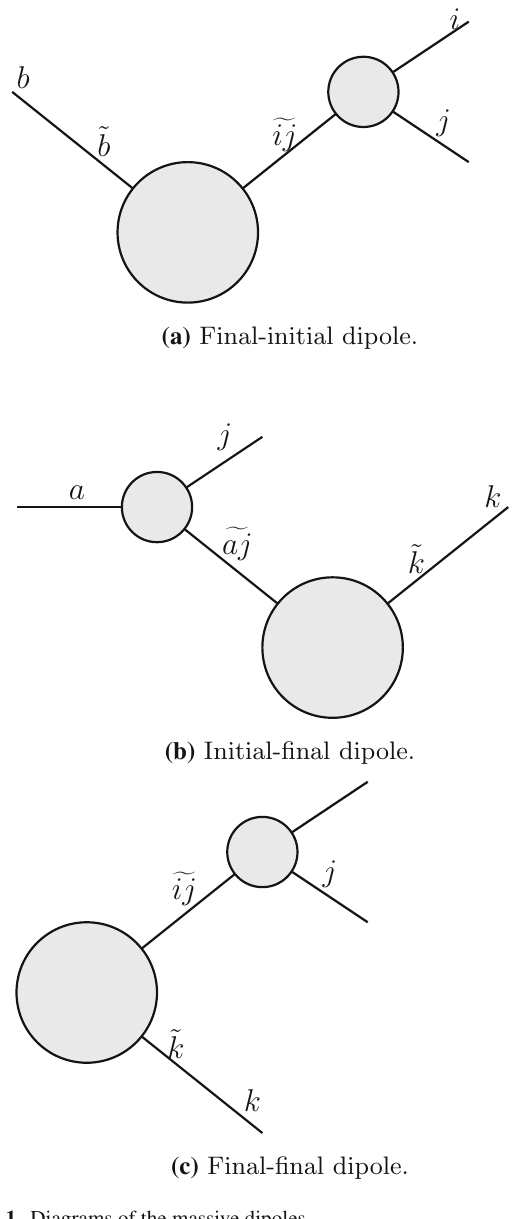
Fig. 1 Diagrams of the massive